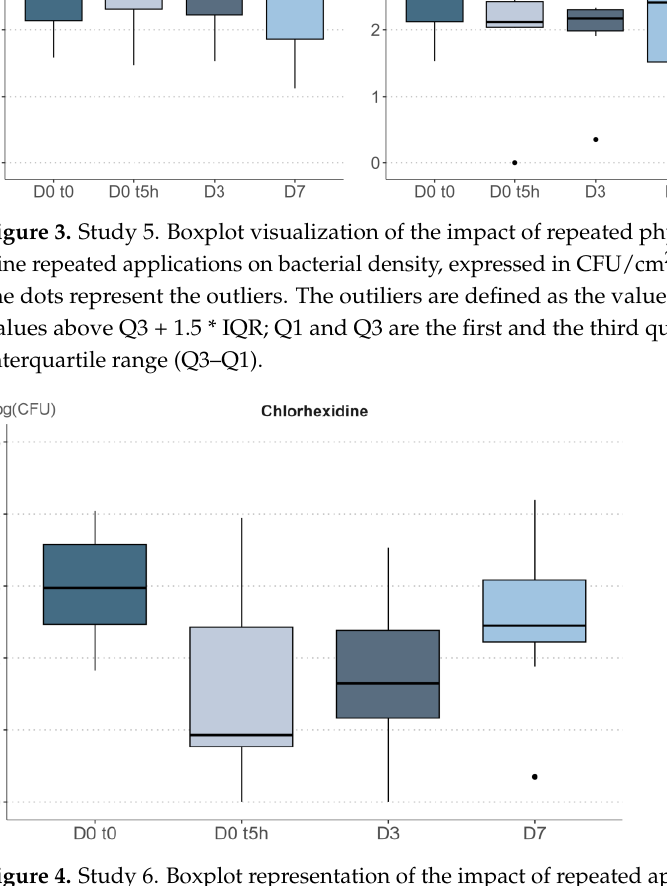
Figure 3. Study 5. Boxplot visualization of the impact of repeated physiological saline or chlorhexi- dine repeated applications on bacterial density, expressed in CFU/cm² on a log-scale. In the boxplot, the dots represent the outliers. The outiliers are defined as the values below Q1 − 1.5 IQR and the values above Q3 + 1.5 * IQR; Q1 and Q3 are the first and the third quartile, respectively, IQR is the interquartile range (Q3–Q1).